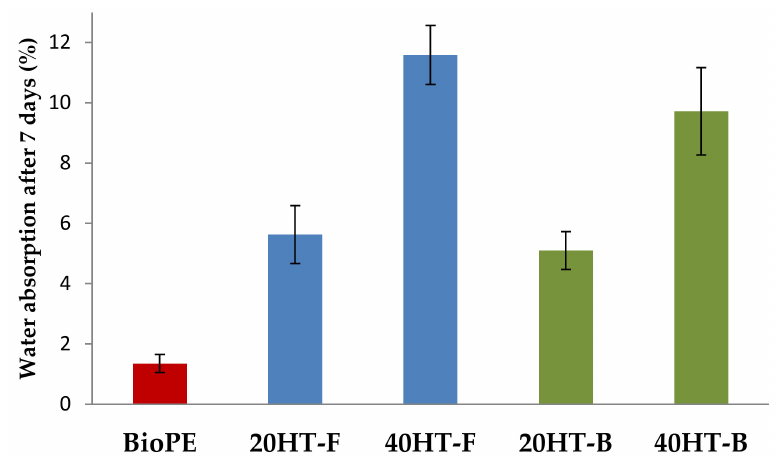
Figure 3. Water absorption of filaments with di ff erent percentages of fibers, using fossil- and bio-based compatibilizers.